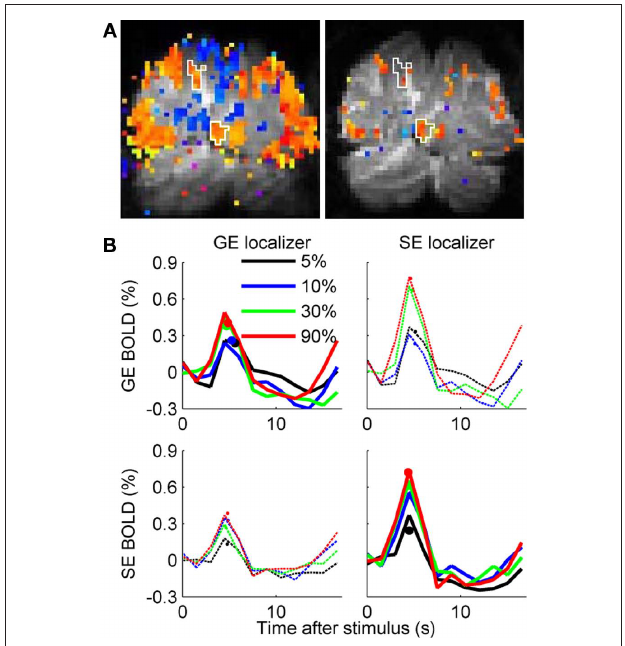
FIguRe 3 | gradient echo (ge) BOLD and Spin echo (Se) BOLD hemodynamic responses to gabor elements of increasing contrast. (A) Block-design functional data with coherence exceeding 0.30 are visualized as color overlays on the gray-scale EPI image for a single pseudo-coronal slice. Orange: increased BOLD response during stimulus presentation; blue: decreased BOLD response during stimulus presentation. GE data are on the left, SE data are on the right. The (identical) white outlines on both images show two sub-ROIs (individual Gabor element representations) defined by the GE BOLD localizer. (B) Estimated hemodynamic responses for one subject’s ROIs (four sub-ROIs) selected by the GE BOLD localizer (left column) and the SE BOLD localizer (right column), measured during GE BOLD (top row) and SE BOLD (bottom row) event-related scans. Dots represent BOLD response amplitude estimated by fitting a difference-of-gamma functions model to the 12 HRF